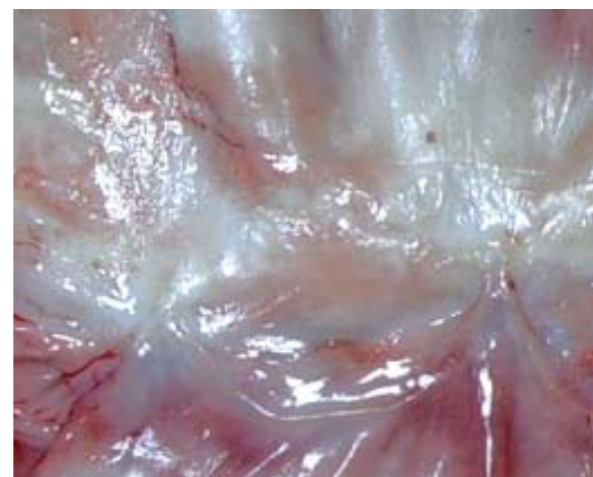
Fig. 2 - Análise macroscópica da cúspide do heteroenxerto descelularizado. Foto demonstrando ausência de espessamento da cúspide do heteroenxerto descelularizado explantado com 9